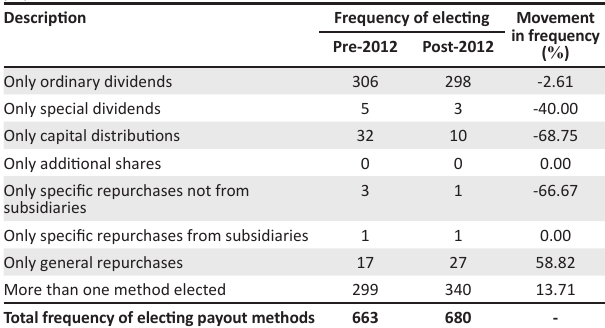
TABLE 2: Movement in frequency of electing payout methods and movement in values.